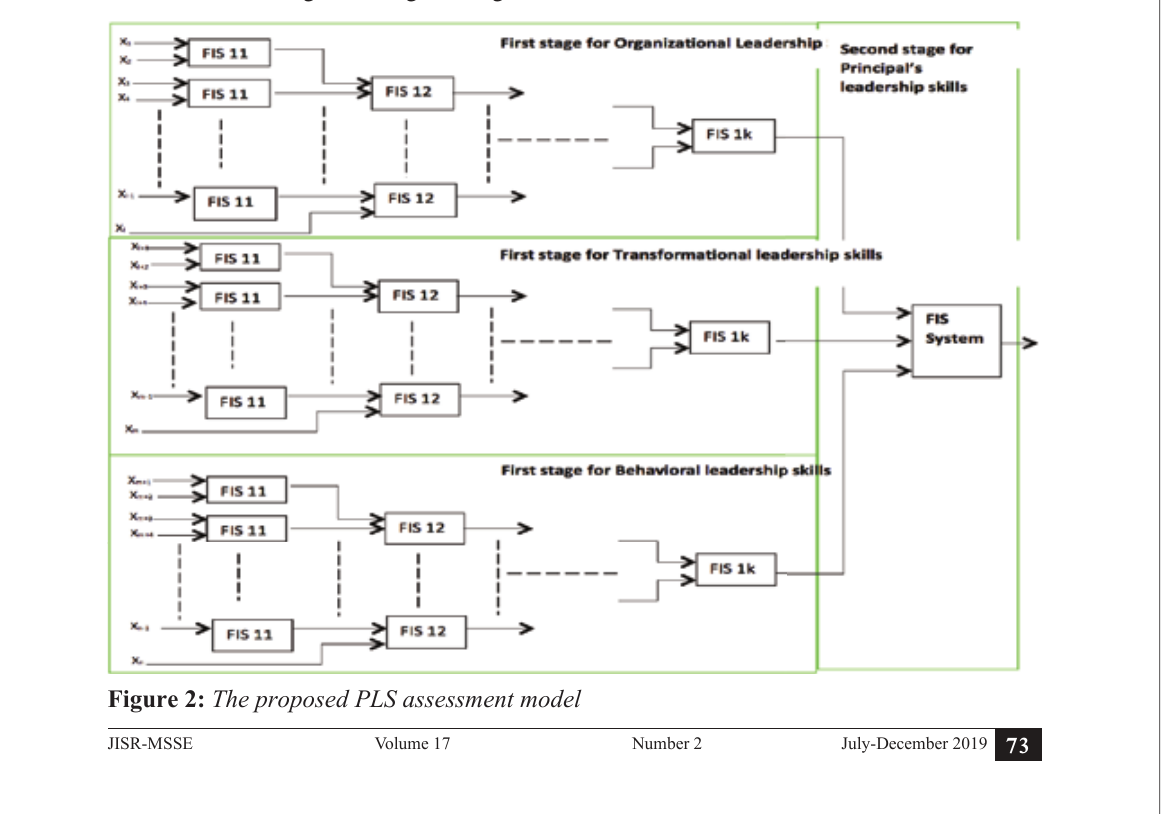
Figure 2: The proposed PLS assessment